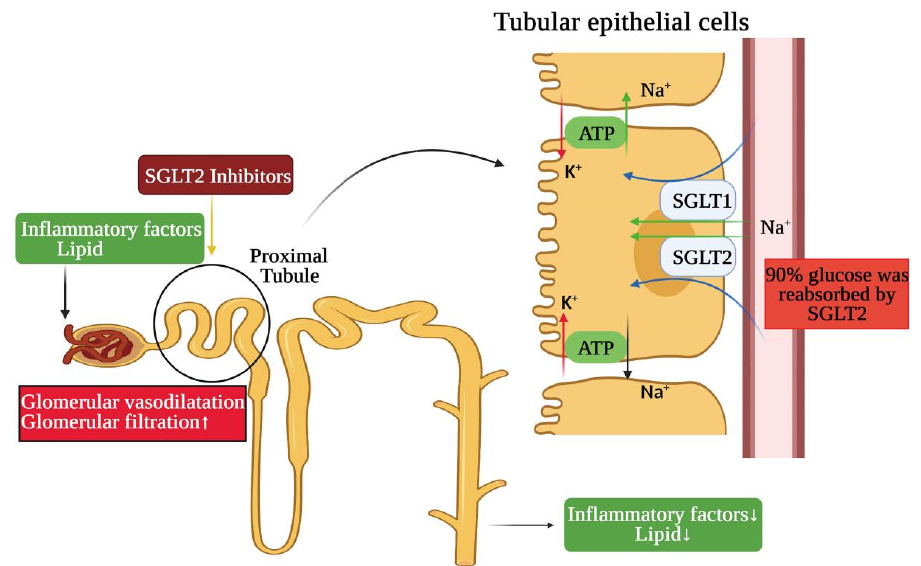
Figure 6. The mechanism of SGLTs and SGLT-2 inhibitors in obesity-related kidney injury. The reabsorption of glucose in the kidney mainly depends on sodium glucose cotransporters (SGLTs), through which glucose and Na + are transported across the membrane. SGLT-2 was mainly expressed in the kidney, while SGLT-1 was partially expressed in the kidney. About 90% of the glucose was reabsorbed by SGLT-2 in the S1 segment (the beginning of the proximal convoluted tubule and the first 1/3 of the convoluted part in the kidney) of the proximal convoluted tubule. However, SGLT-2 can also regulate inflammatory factors and lipids in proximal tubules, activate glomerular feedback and decrease the glomerular filtration rate, so as to slow down the progression of kidney disease. SGLT ‐ 1, sodium ‐ dependent glucose transporters 1; SGLT ‐ 2, sodium ‐ dependent glucose transporters 2. “ ↑ ” represents an increase, and “ ↓ ” represents a decrease.